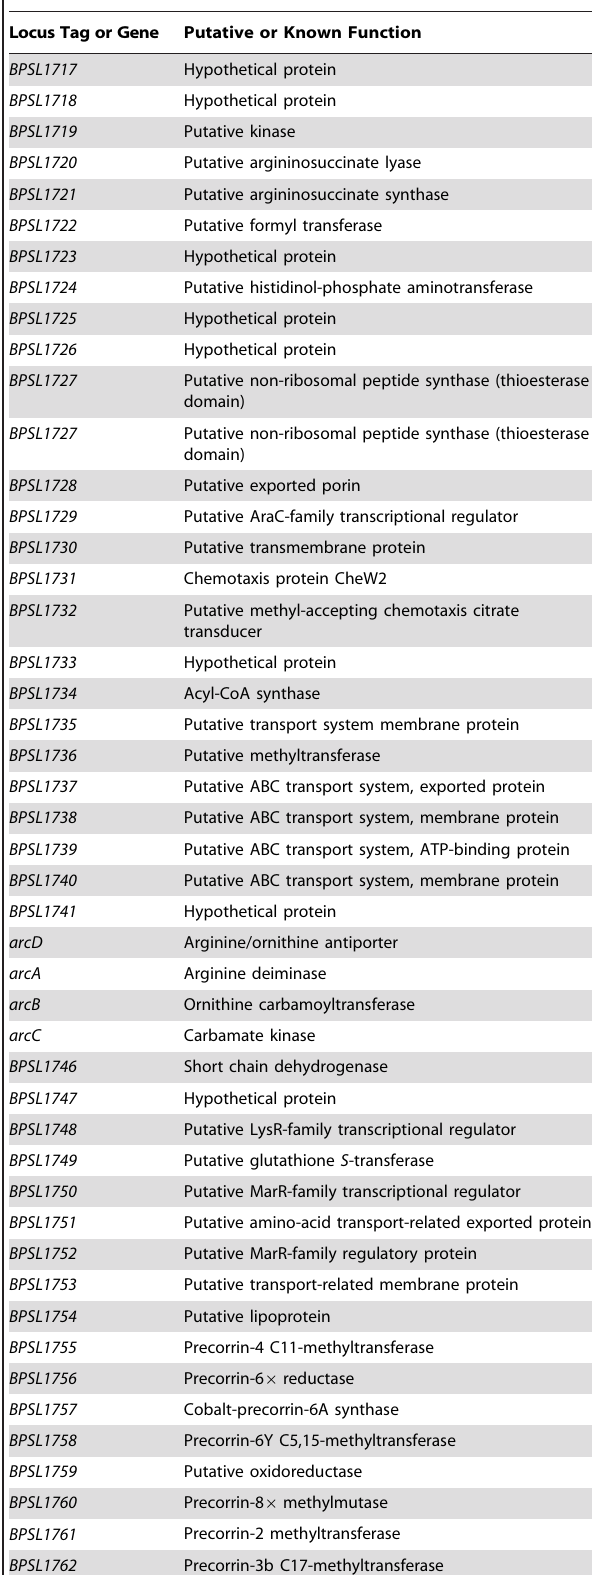
Table 4. K96243 gene equivalents contained within the 708a chromosome 1 deletion.